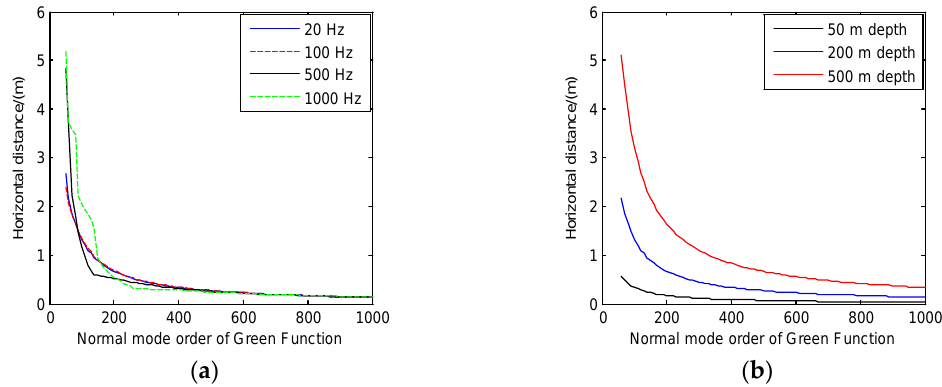
Figure 3. The near field accuracy of the Green’s function at different frequencies or different depths. ( a ) Accuracy of different frequencies at a depth of 200 m; ( b ) Accuracy of different depths at a frequency of 20 Hz.